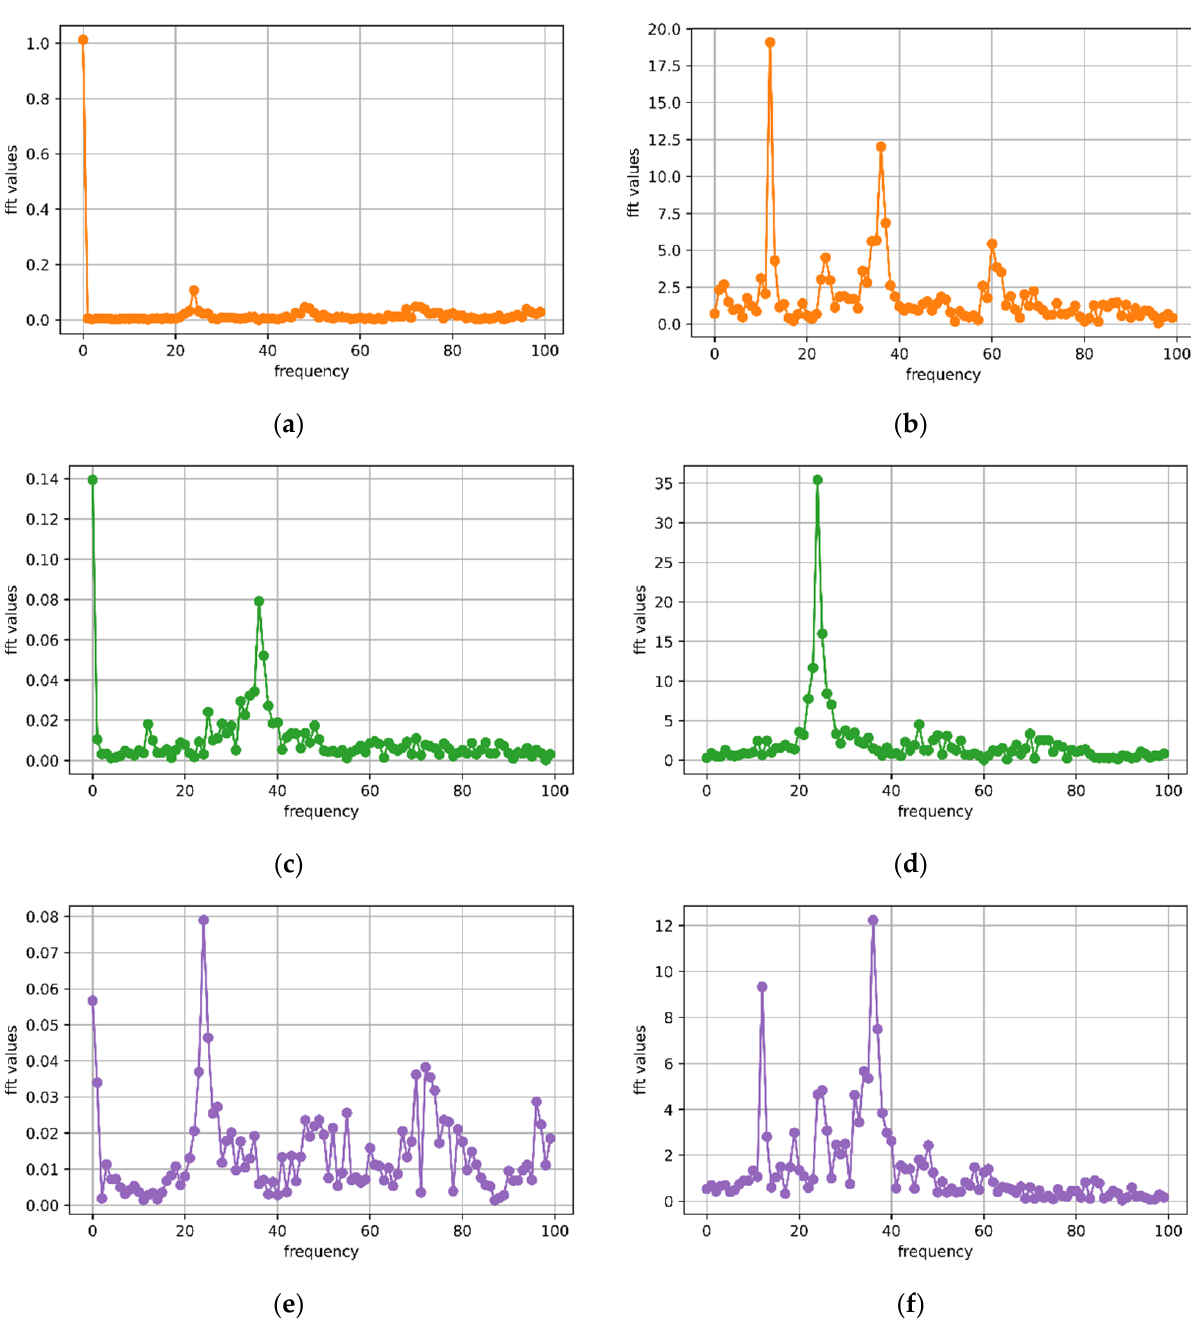
Figure 4. Fourier transform performed on the three-axis accelerometer and three-axis gyroscope signals of the 10 s walking behavior shown in Figure 3 to calculate the main frequency and period.